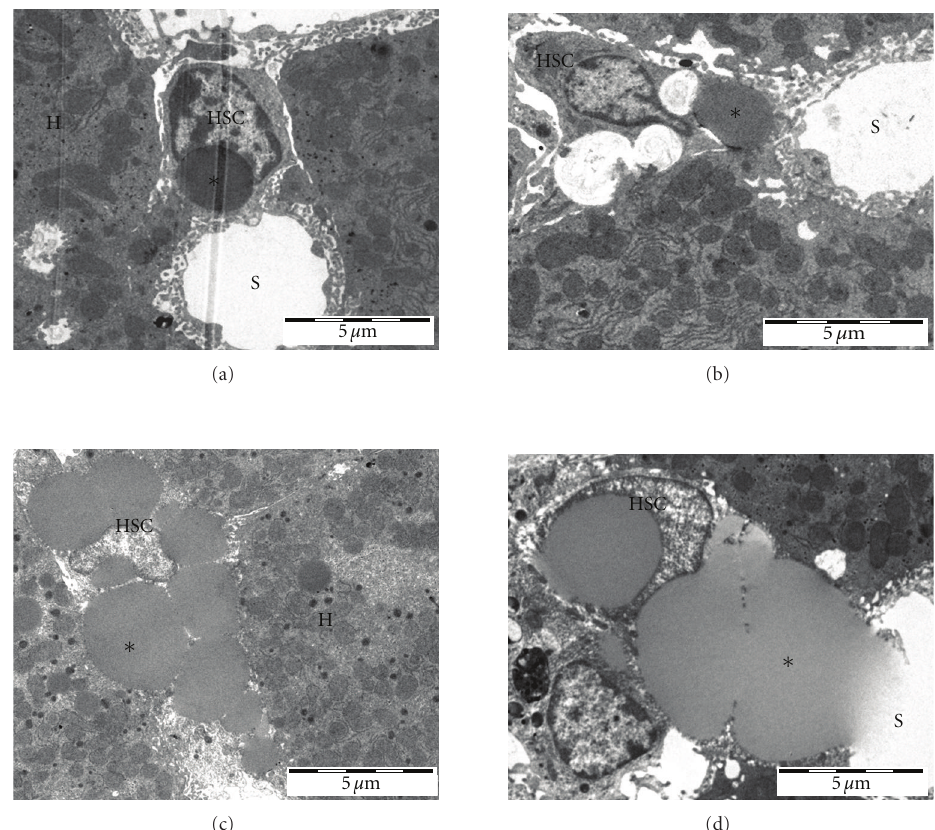
Figure 2: Representative transmission electron micrographs of HSC (HSC) from young (a,b) and old mice (c,d). Hepatic Stellate Cell HSC; Sinusoidal lumen S; Hepatocyte H; Lipid droplets ∗ .